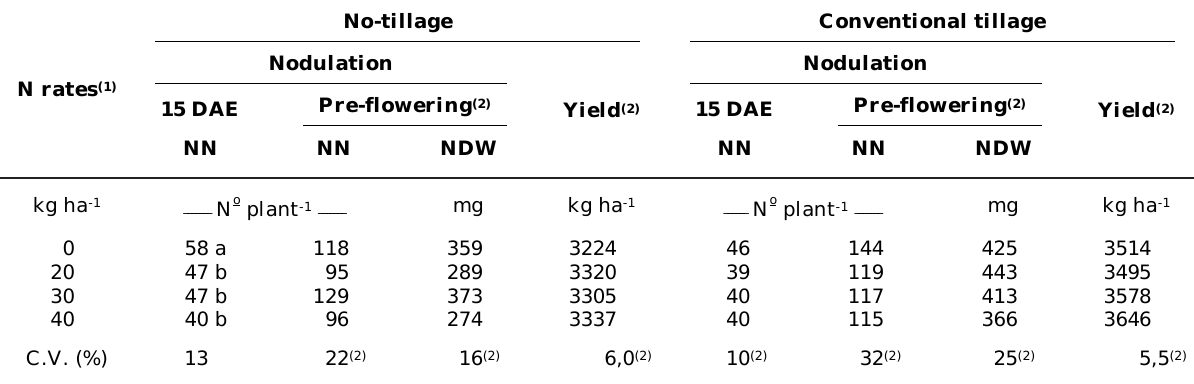
Table 3. Effects of starter N rates on nodulation per plant (nodule number, NN; nodule dry weight, NDW) and on grain yield of the soybean cultivar Emgopa 316 grown under no-tillage (NT) and conventional tillage (CT) systems, in 1999/2000